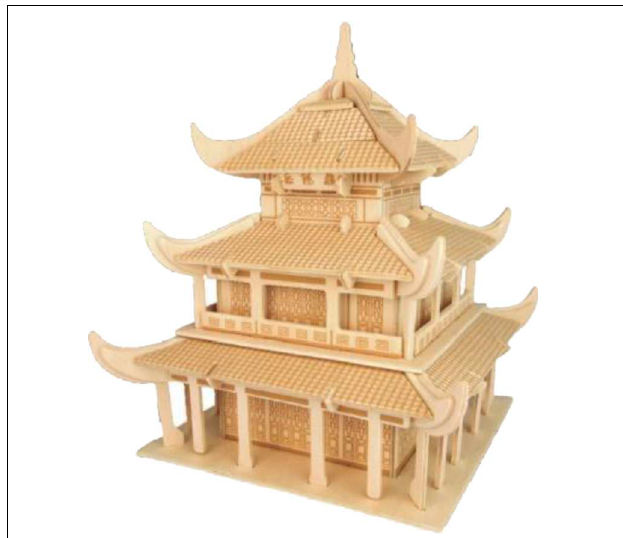
FIGURE 1 | Reference materials used: Yueyang